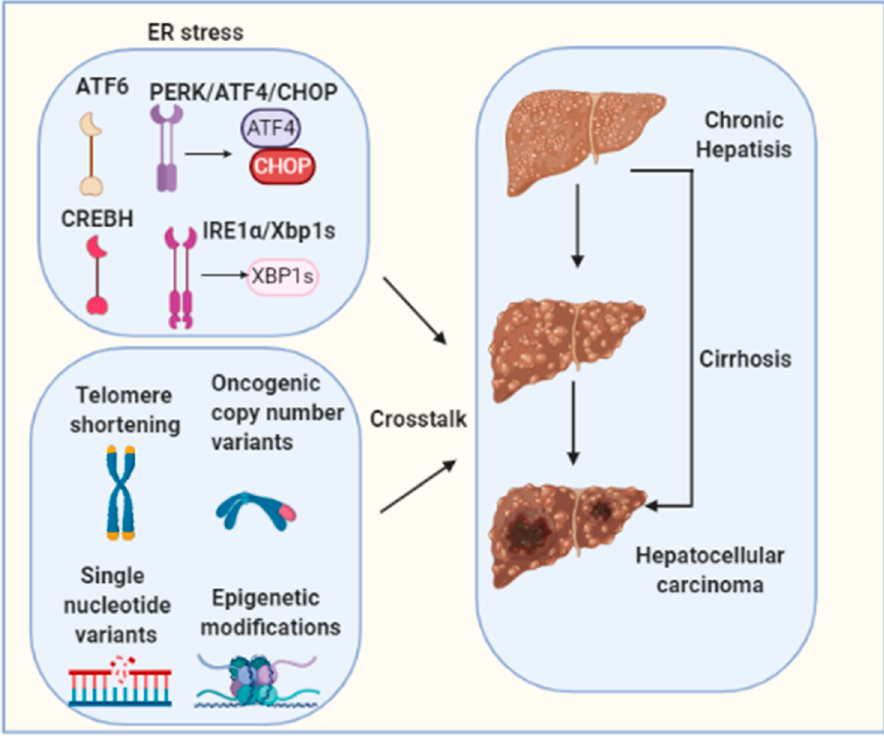
Figure 3. Hepatocarcinogenesis is a complex multistep process involving multiple different signaling cascades’ activation. Telomere shortening, oncogenic copy number variants, single nucleotide variants and epigenetic modifications are well-established molecular mechanisms for HCC tumorigenesis. The molecular crosstalk between these factors and ER stress needs to be further investigated.